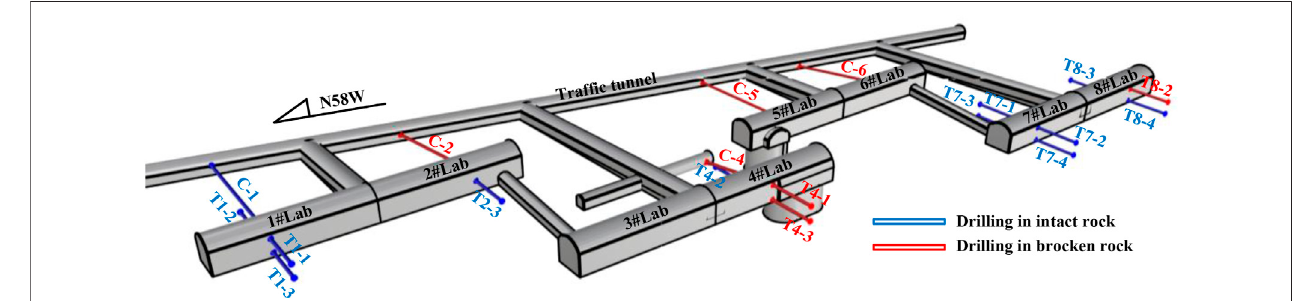
FIGURE 6 | Drilling arrangement in engineering case.